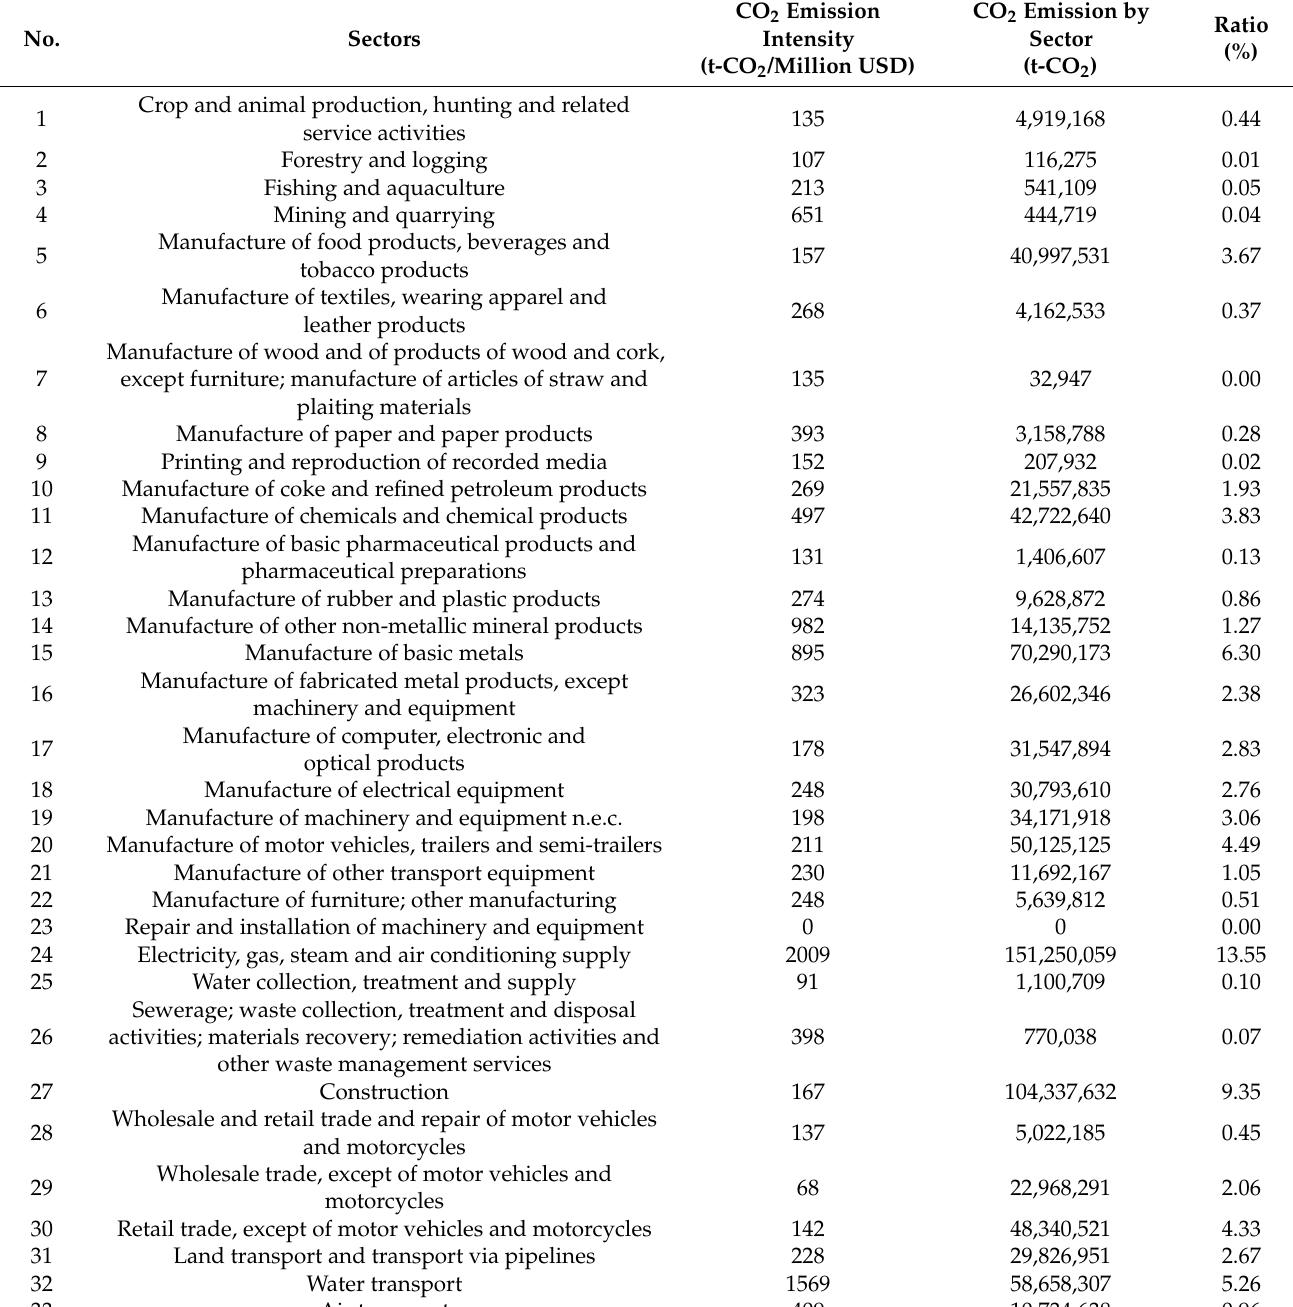
Table 3. CO 2 emission intensities (JPN,